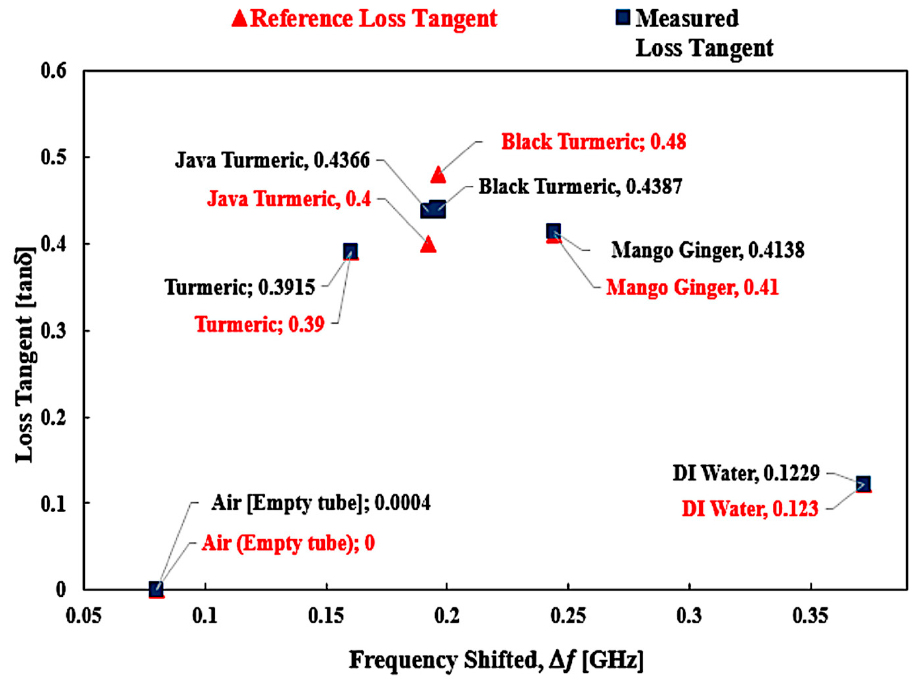
Figure 19. Comparison of the ideal and measured loss tangent of several SUTs (semi-solid).